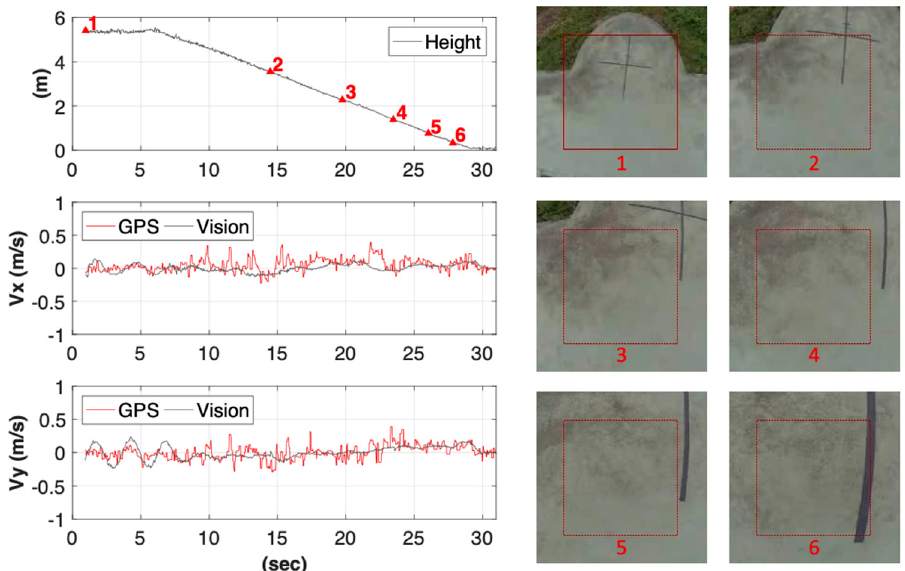
Figure 10. The UAV’s states during visual landing. The reference ROI were updated by the multi-scale phased correlation method based on flight height accordingly, and the resulting velocity estimates of the vision system (black line) followed a similar trend with GPS (red line), with a standard deviation of error about 0.1 m/s in both directions.